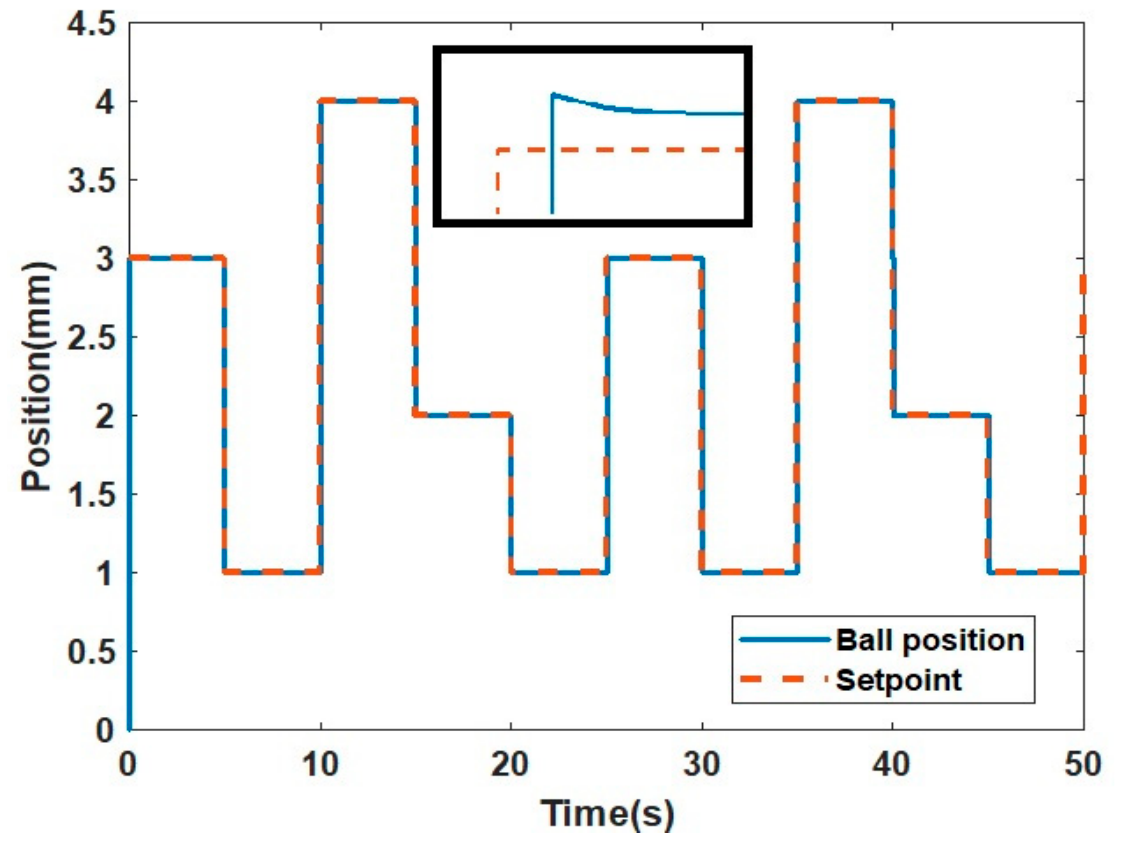
Figure 16. The responses of CFOPID and PID controllers.